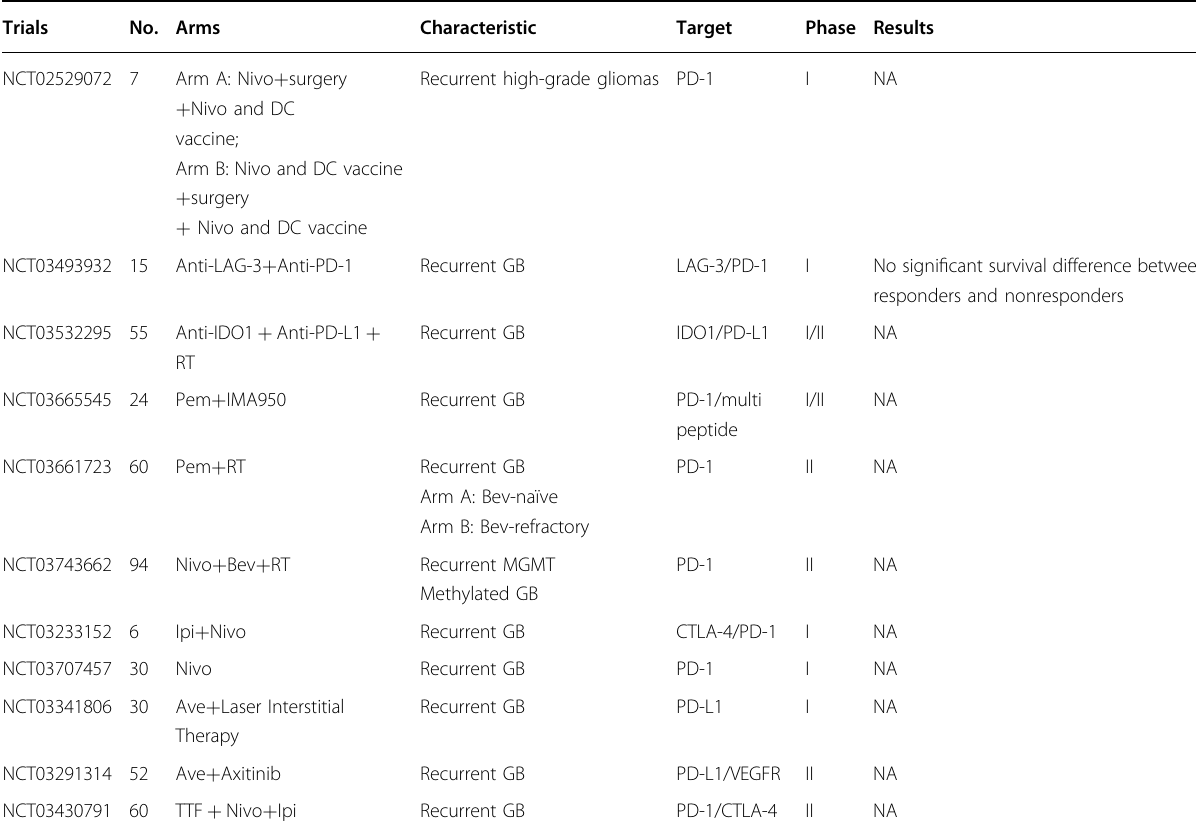
the clinical responses to WT1 vaccination in rGB